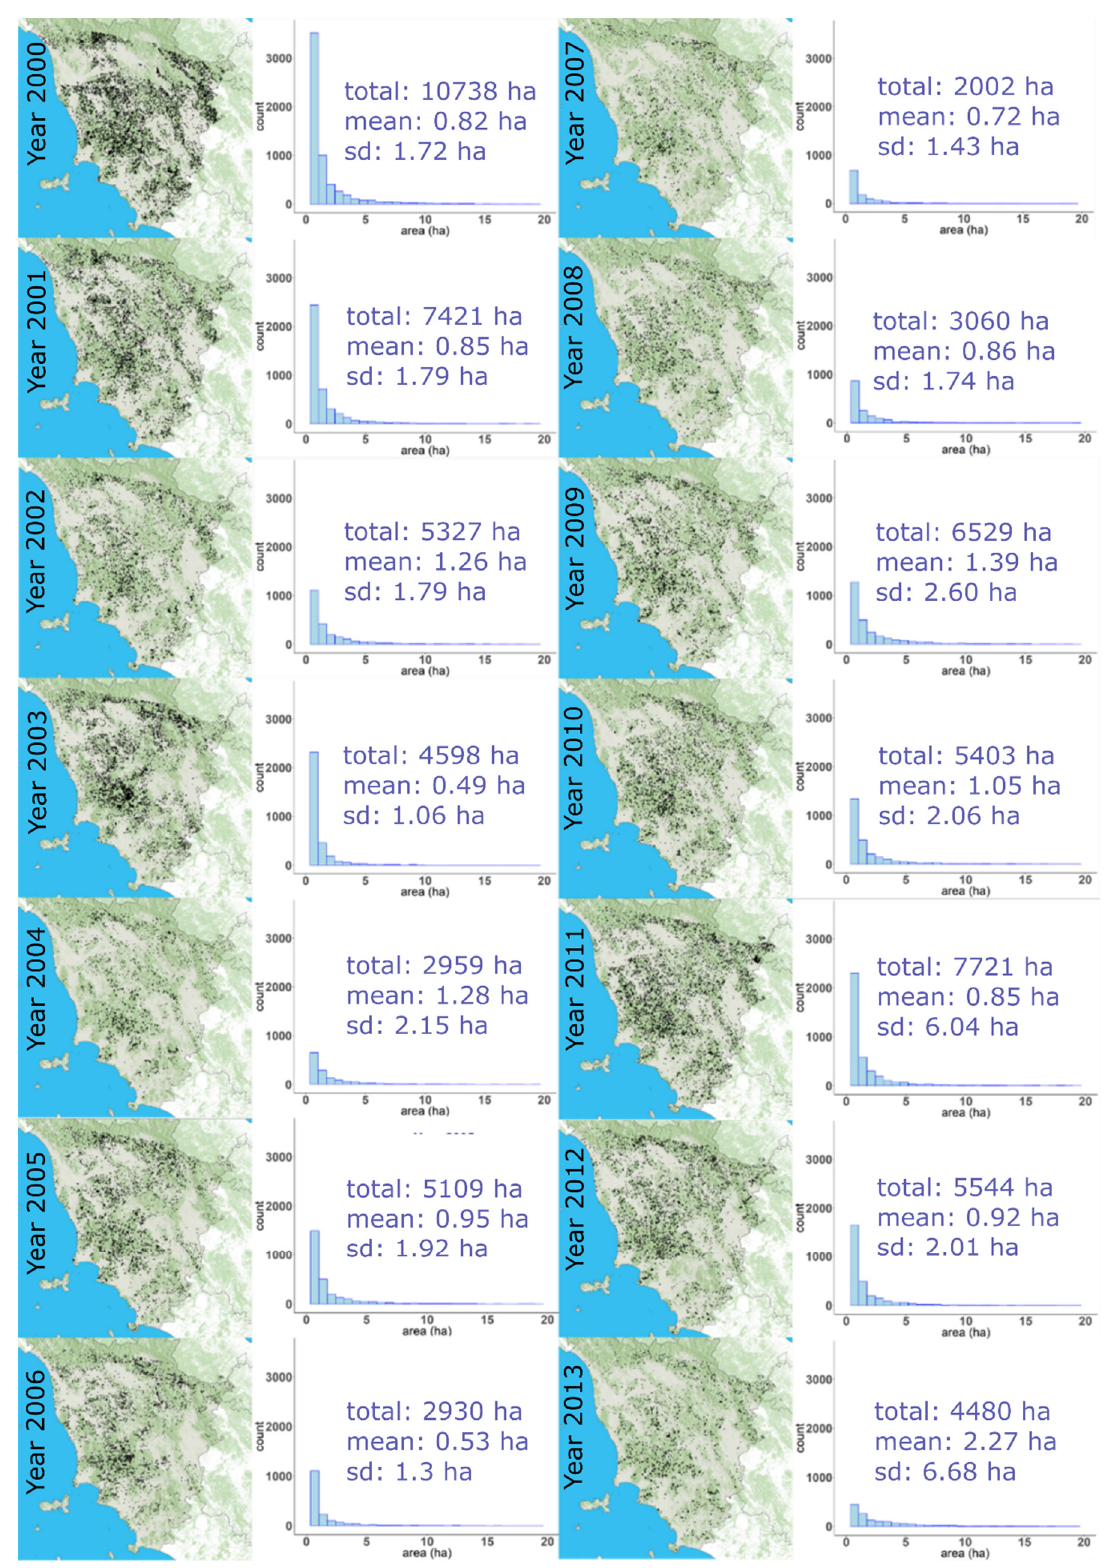
Figure 6. Final clearcuts maps obtained with the TTM algorithm and related frequency histograms of sizes of clearcut areas within the portion of Landsat scene 192 030 within the borders of Tuscany Region.